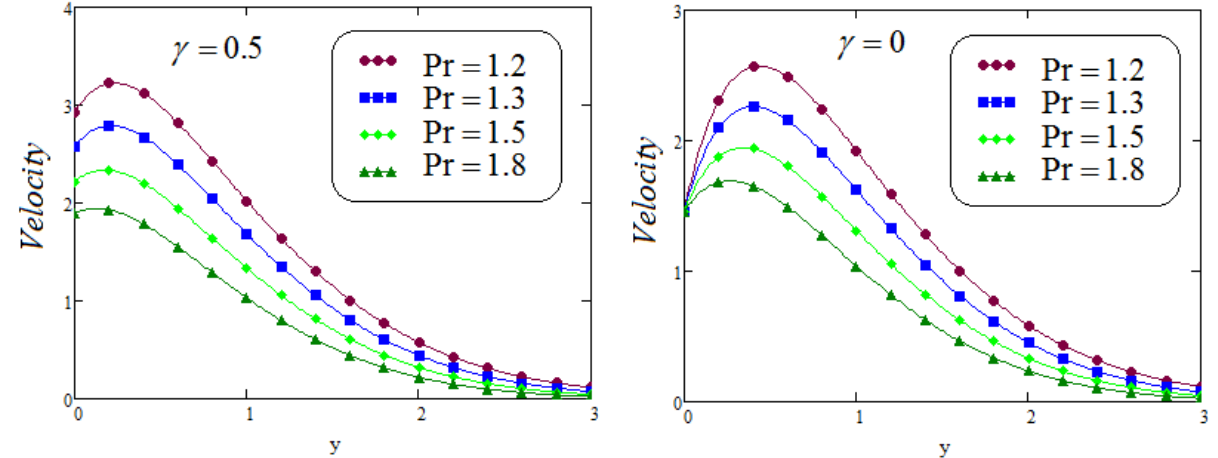
Figure 3. Velocity field under slip conditions as well as the velocity field under no-slip conditions for different Pr values when f ( t ) = e at , a = 0.25, t = 1.5, Gr = 3.5, λ 1 = 0.6, λ 2 = 0.2, M = 2.